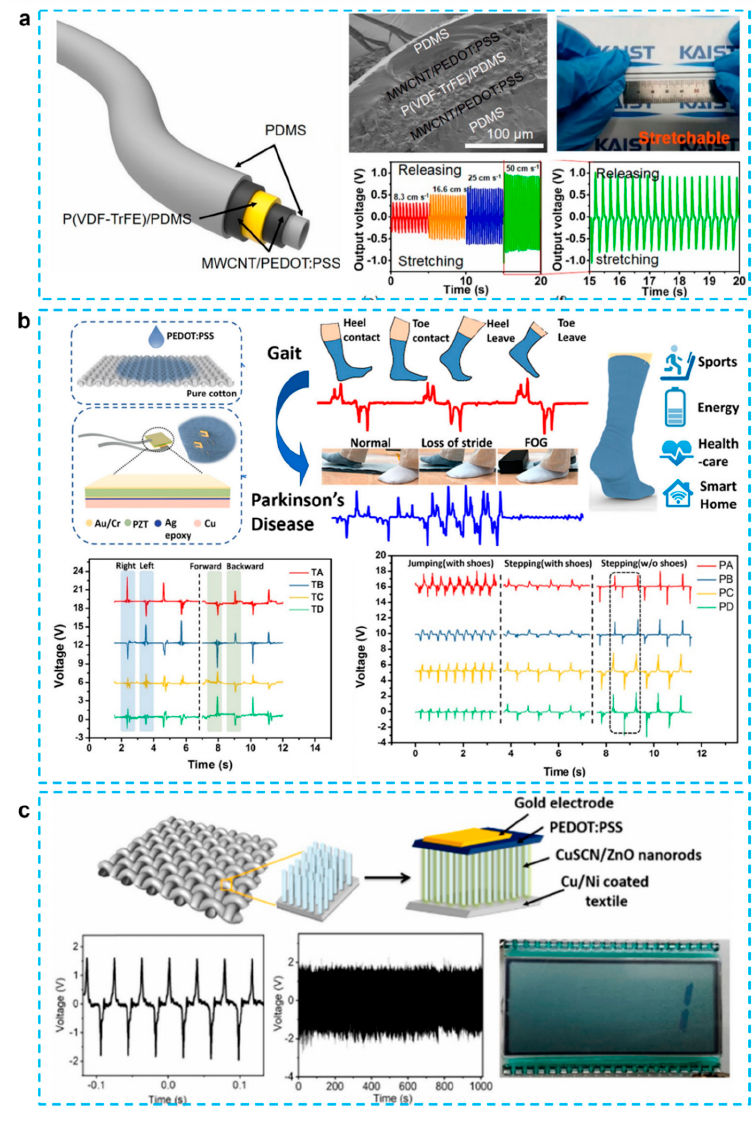
Figure 6. ( a ) Intrinsically stretchable multi-functional fiber with energy harvesting and strain sensing capability [31]. ( b ) Self-powered and self-functional cotton sock using piezoelectric and triboelectric hybrid mechanism for healthcare and sports monitoring [43]. ( c ) P-N junction-based ZnO wearable textile nanogenerator for biomechanical energy harvesting [32].